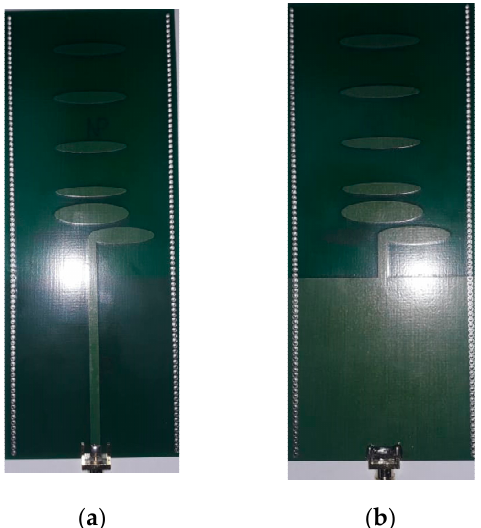
Figure 6. Photograph of the fabricated proposed antenna ( a ) front view ( b ) back view.